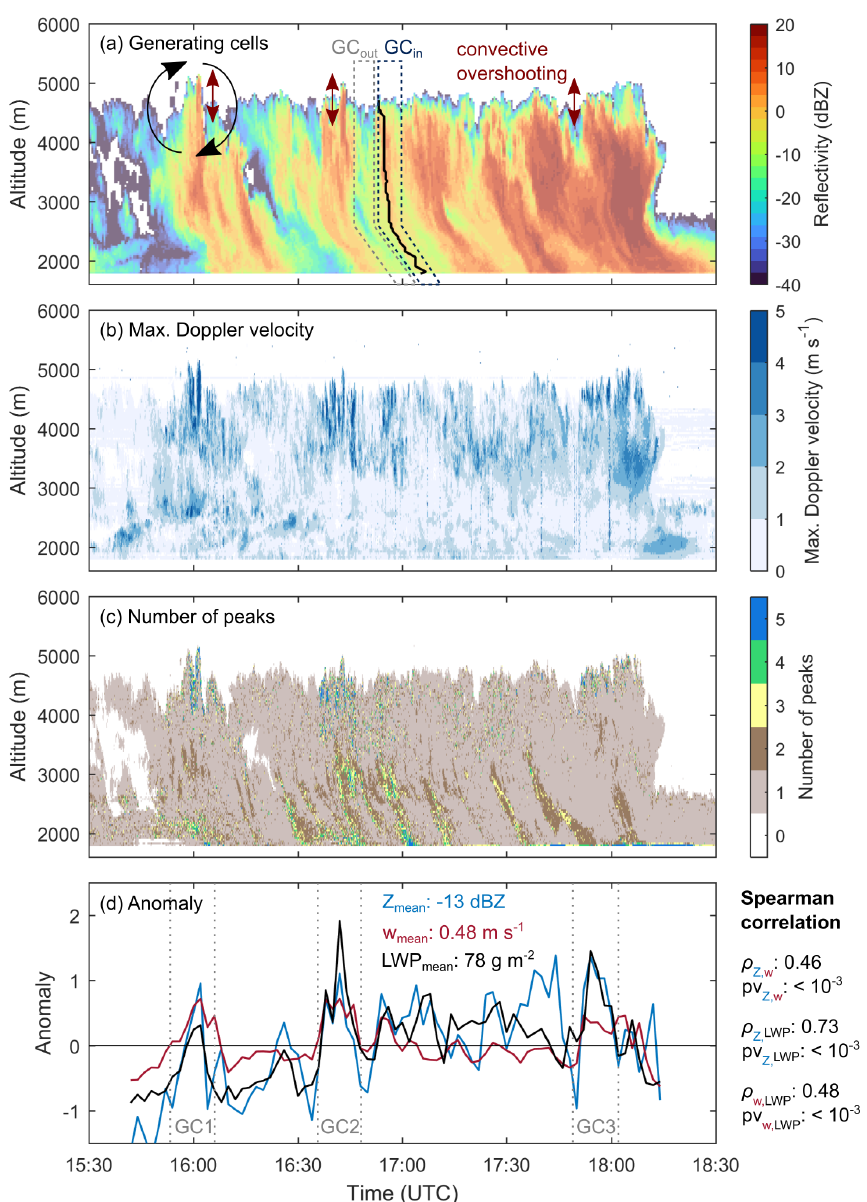
Figure 8. Time series of the radar reflectivity (a) , maximum Doppler velocity (b) and number of peaks (c) . The black line in panel (a) shows the 17:00UTC fallstreak, and the dashed lines indicate the regions inside (GC in ) and outside (GC out ) of the 17:00UTC fallstreak which were used for the analysis in Fig. 9. The maximum Doppler velocity was derived from the Doppler spectra (see Appendix A). The number of peaks were obtained from the peakTree analysis (see Sect. 2.3.2). The evolution of the cloud top anomalies is shown in (d) . The radar reflectivity (blue line) and spectral width (red line) were averaged over 600m from the cloud top. The anomalies were normalized to the mean value, which is indicated in panel (d) . The results of the Spearman’s rank correlation are shown to the right of panel (d) , with ρ indicating the correlation coefficient and pv the p value of the Spearman’s rank